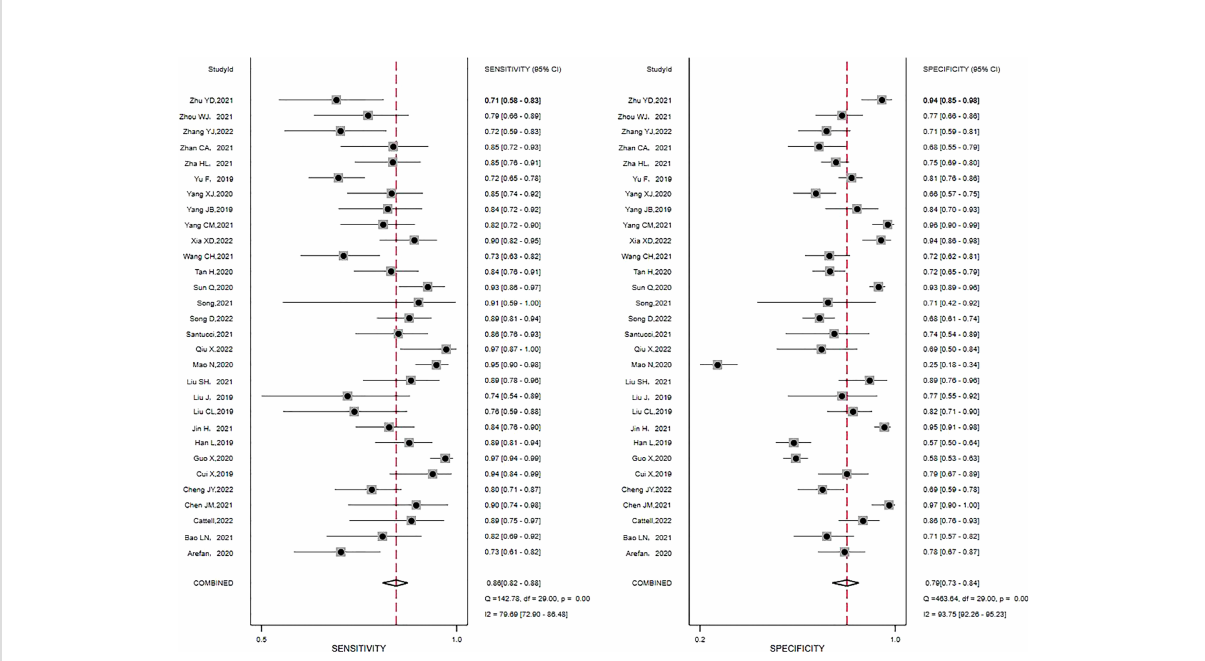
FIGURE 3 Forest plots of the sensitivity and speci fi city of radiomics in predicting ALNM in breast cancer. Numbers are pooled estimates, with 95% CIs depicted with horizontal lines. Heterogeneity statistics are shown at bottom right. I 2 >50% indicates substantial heterogeneity in the diagnostic parameters across